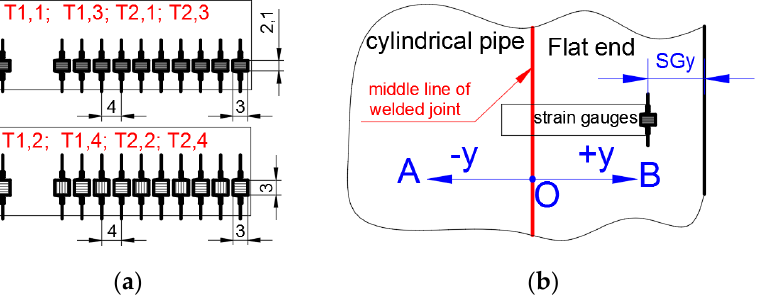
Figure 5. Information about strain gauges: ( a ) dimensions of strain gauge chains; ( b ) location of strain gauges on vessel surface (length SGy ) and definition of axis y and points (A, O, B) for presentation of results. Table 2. Position of strain gauge chains. Distance SGy determines center of first strain gauge from end of vessel.